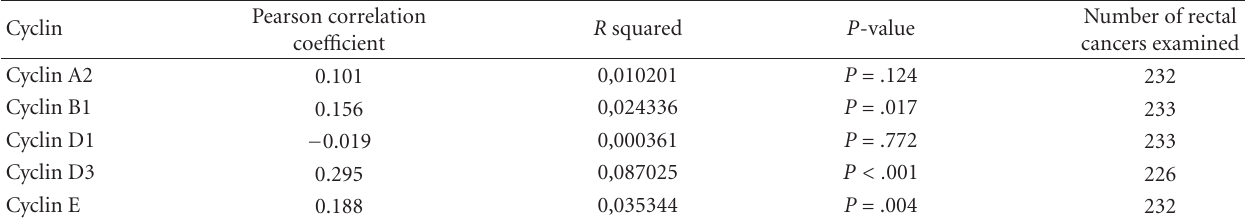
Table 7: Correlation between protein expression and gene amplification of cyclins in rectal cancers.